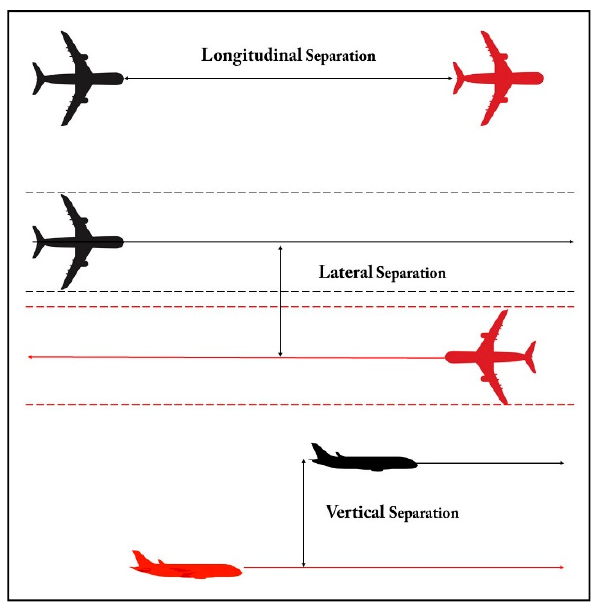
Figure 2. Longitudinal, lateral, and vertical separation. Source: The authors .